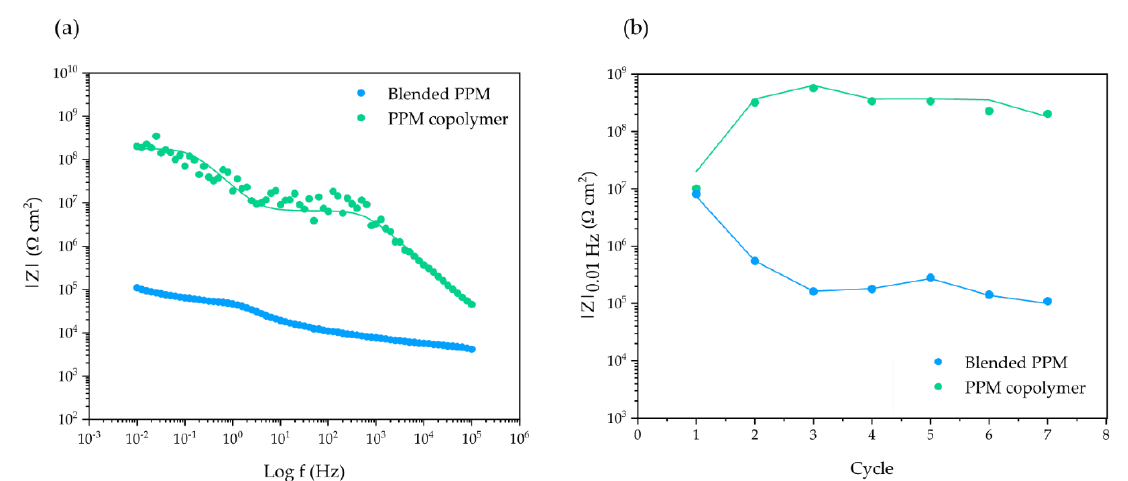
Figure 6. Evolution of the Bode modulus plot in ACET experiments during the last cycle ( a ); the fitted data are represented by lines while the experimental values are represented by circles. Evolution of |Z| 0.01Hz over the whole ACET cycles ( b ); dotted lines represent a guide for eye only. In both graphs: 30 μm coating of PPM copolymer (green) and of blended PPM (blue).